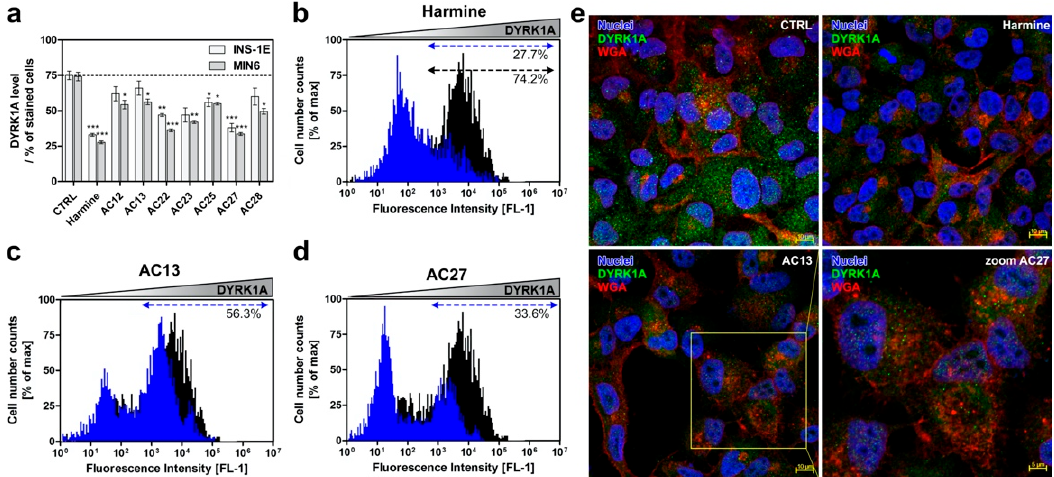
Figure 6. DYRK1A expression in the investigated rodent cell lines. ( a – d ) Flow cytometry analysis of DYRK1A expression in MIN6 cell line. After incubation of cells with inhibitors (24 h), the cells were stained with a DYRK1A antibody. ( a ) DYRK1A expression levels in cells treated with the investigated compounds; data are expressed as % of max in control cells. ( b ) DYRK1A expression levels in control cells (black) and harmine-treated cells (blue). ( c ) DYRK1A expression levels in control (black) and AC13-treated cells (blue). ( d ) DYRK1A expression levels in control (black) and AC27-treated cells (blue). ( e ) Immunofluorescence double-staining with antibodies against DYRK1A (green) and cell membrane (red) of MIN6 cell line without (CTRL) and after treatment with harmine (upper right) and AC27 (lower panel). Cell nuclei were stained with Hoechst 33,342 (blue). Scale bars, 10 µ m and 5 µ m for zoom, respectively. Data are expressed as mean ± SEM, N = 3; * p < 0.05, ** p < 0.01; *** p < 0.001 as compared to control.